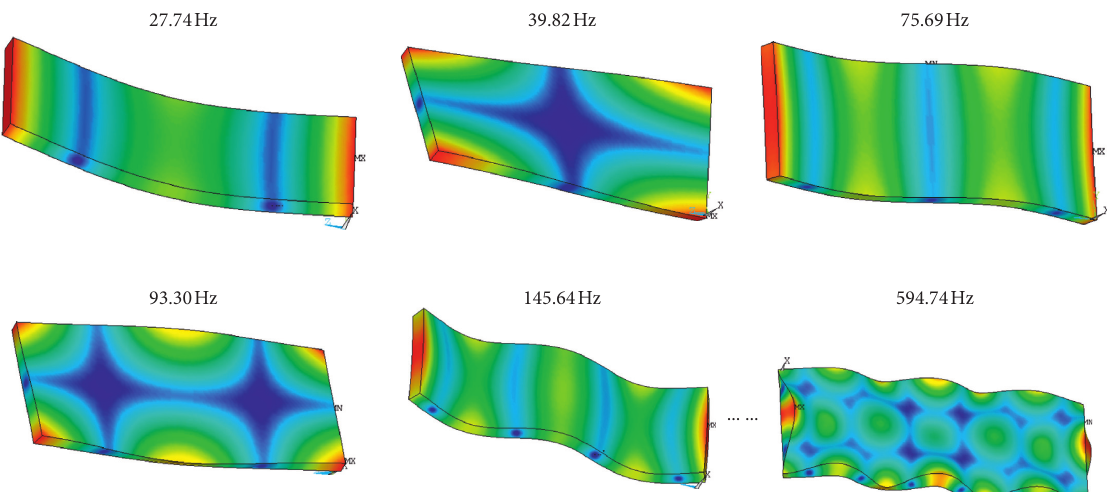
Figure 3: Partial modal shape of the slab track.